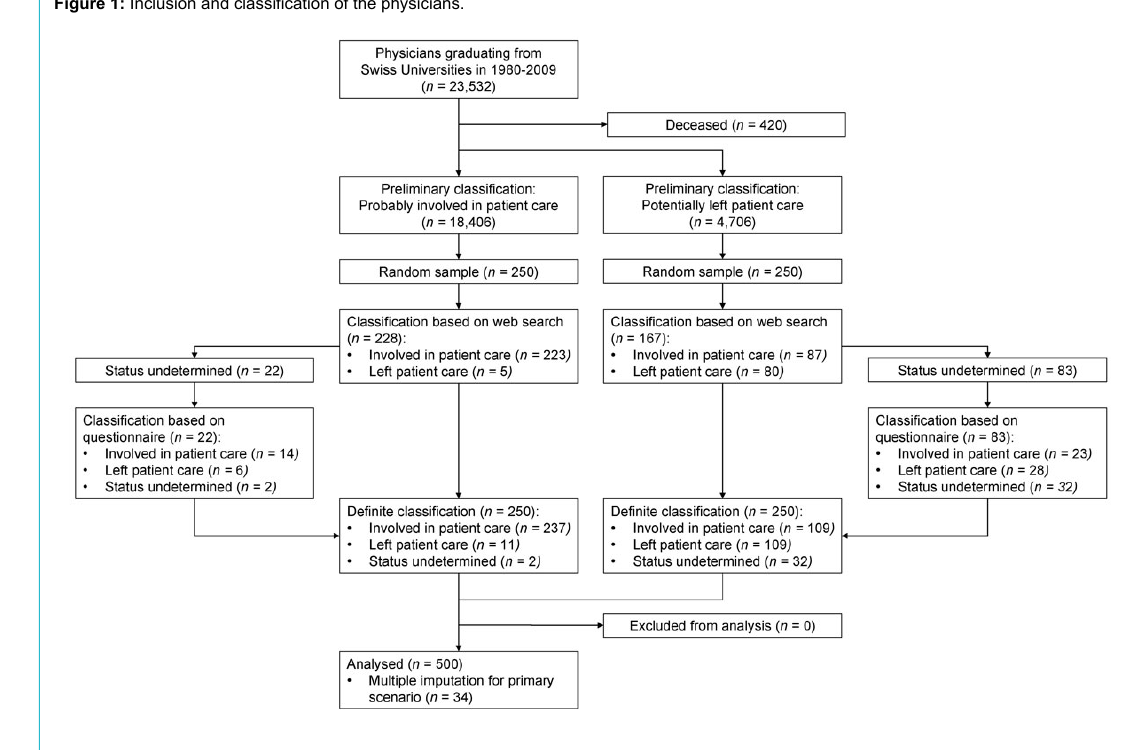
Figure 1: Inclusion and classification of the